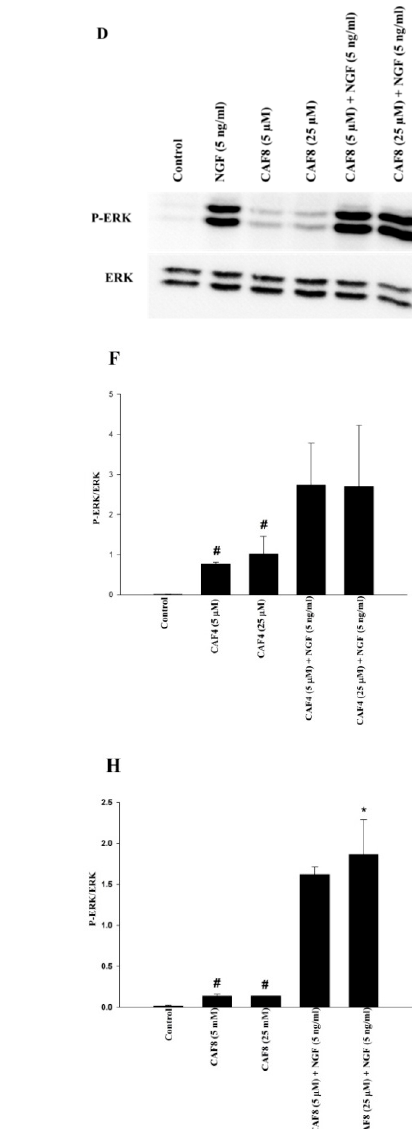
Figure 5. Assessment of extracellular signal ‐ regulated kinase (ERK1/2) phosphorylation in PC12 cells treated with synthesized caffeate esters. PC12 cells were seeded in collagen ‐ coated petri dishes and were exposed to caffeate esters and/or NGF (5 ng/mL). After 120 min, the total cell protein was harvested, separated by 7.5% SDS − PAGE, transferred onto a PVDF membrane and probed with specific antibodies ( A – D ). The band intensities of p ‐ ERK1/2 and ERK were quantified. The intensity of each p ‐ ERK1/2 band was first divided by the band intensity of the respective ERK. The p ‐ ERK/ERK ratio in drug ‐ treated cells was normalized to this ratio in NGF ‐ treated cells ( E – H ). The figures show the mean of three experiments ± SEM. # Significantly different from untreated control cells ( p < 0.05). * Significantly different from cells solely treated with NGF (5 ng/mL) ( p < 0.05). As shown in Figure 6A–D, CAF3 and CAF4 did not induce detectable Akt phosphorylation at 5 and 25 μ M when compared with the control, but CAF7 (at 5 and 25 μ M) and CAF8 (at 25 μ M) significantly induced Akt phosphorylation. The concomitant incubation of CAF3, CAF4, CAF7, and CAF8 with NGF (5 ng/mL) increased Akt phosphorylation (producing 1.6/1.6, 1.2/1.3, 1.2/1.5, and 1.7/1.7 folds, respectively, at 5/25 μ M); these changes were not statistically significant, however (Figure 6E–H).